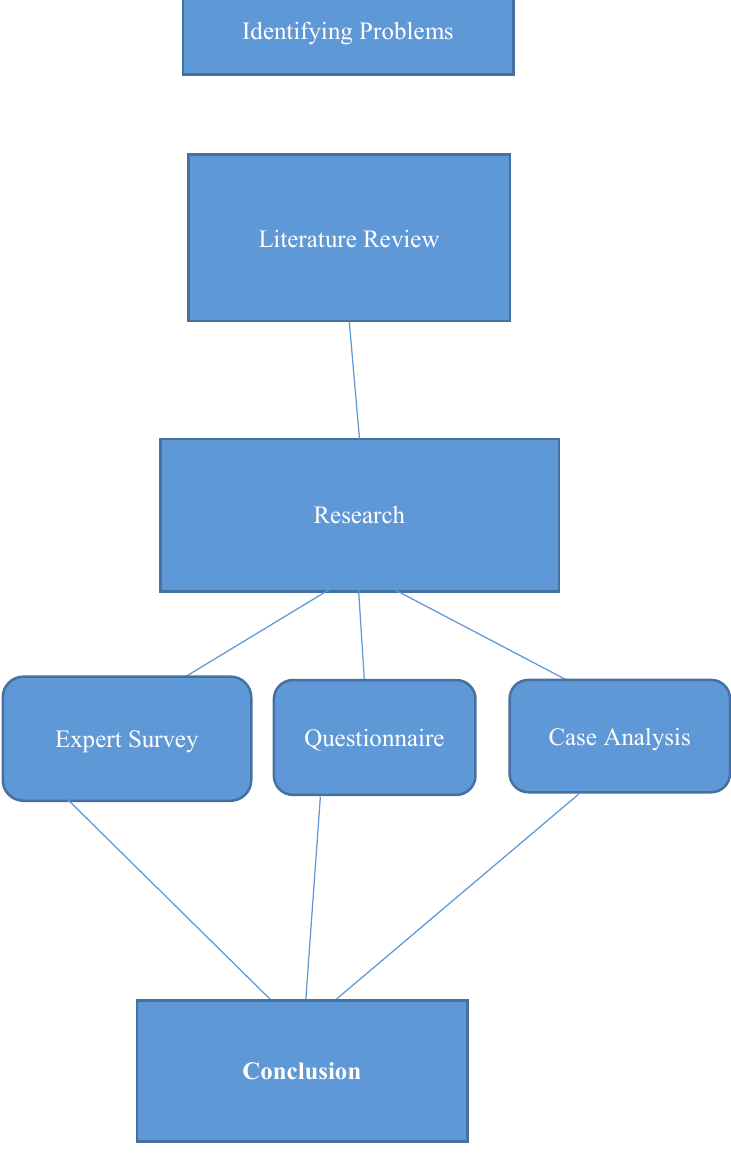
Fig. 1. Project activity flow